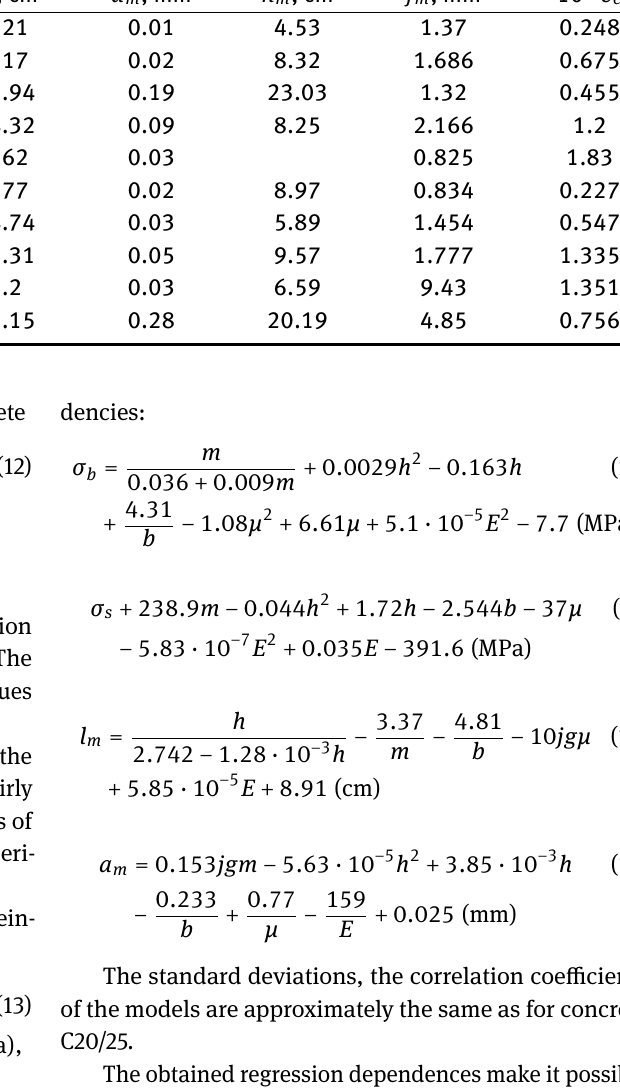
Table 2: Fragment of the result of the bending experiment for concrete C20/25 No X , cm σ b , MPa N a , kN l m , cm